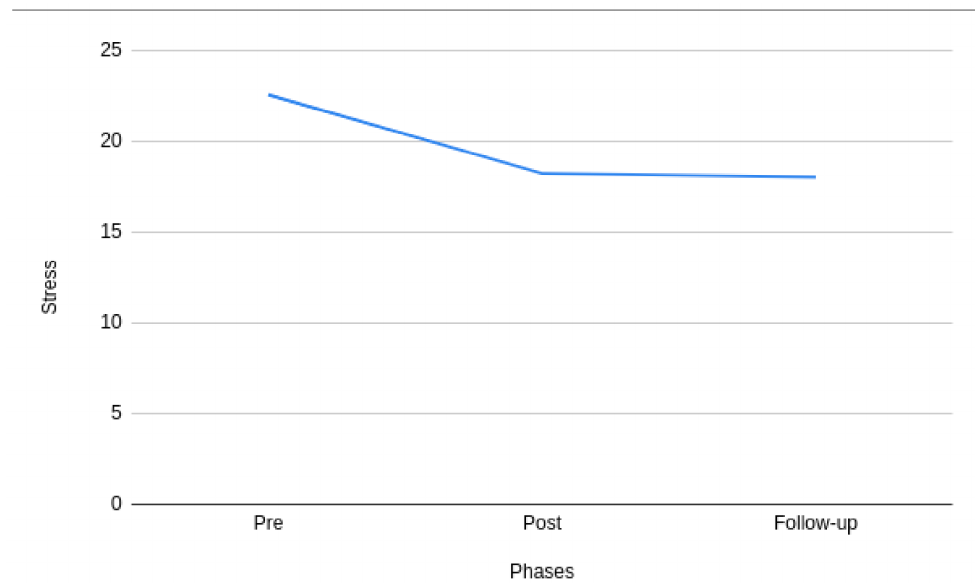
self-esteem.Figure 2. Pre-, post-, and follow-up phases of